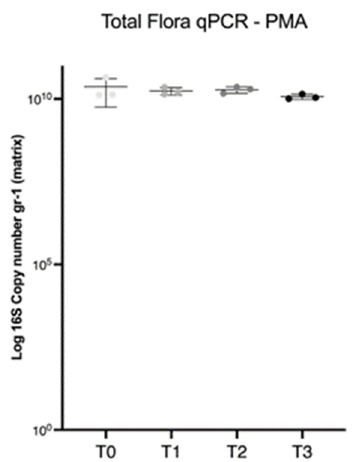
Figure 5. Scatterplot depicting the total bacteria V2–V3 16S estimated by qPCR analysis in the PMA- treated aliquots of the fresh feces (T 0 ) and in the fecal filtrate obtained at the different steps of the fecal manipulation procedure (T 1–3 ). Each dot represents a subsample (A, B, C). Based on ANOVA analysis, the estimated total bacteria (mean) by the means of qPCR in the final fecal filtrate (T 3 ) (1.2 × 10 10 gene copies/g) were not significantly different from the initial fecal sample (T 0 ) (2.3 × 10 10 gene